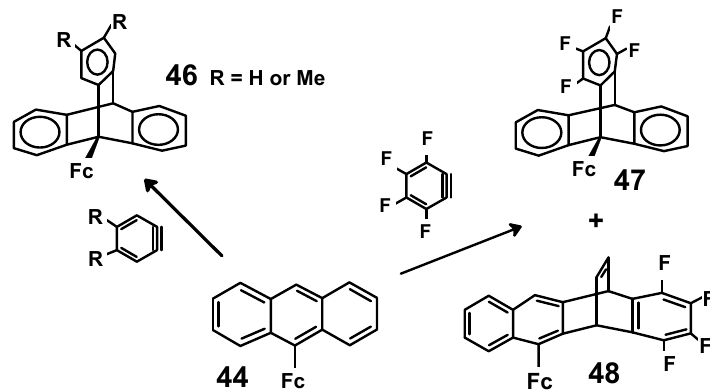
Figure 9. Molecular structure of 43 , the double benzyne adduct to 2-phenylindene.